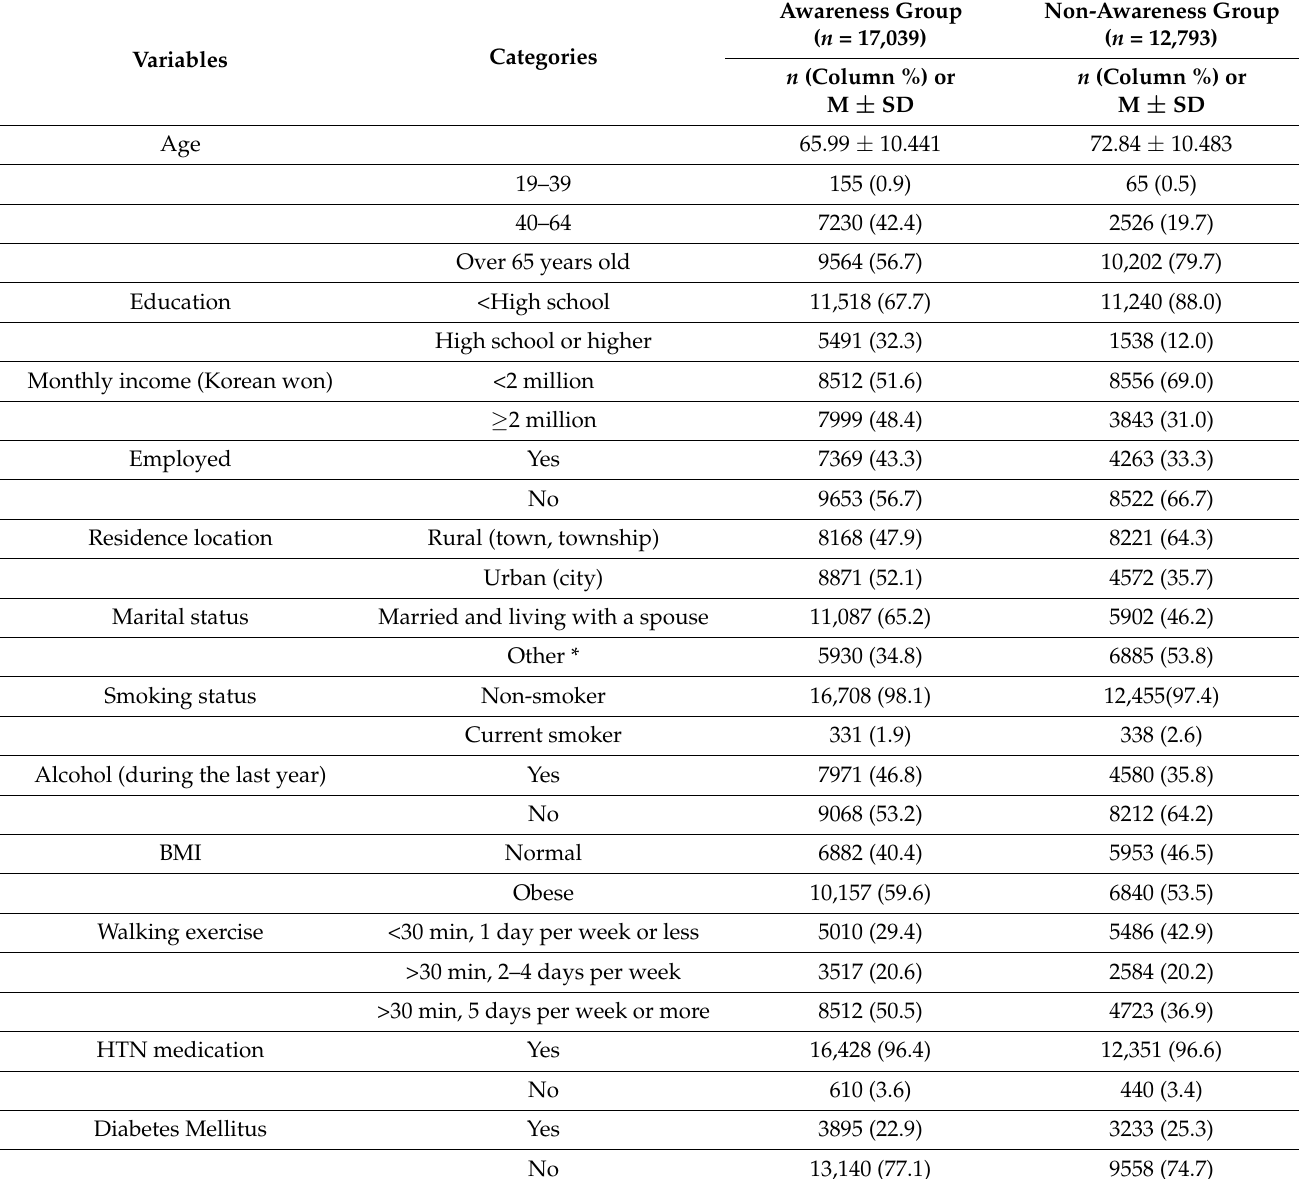
Table 1. General characteristics according to blood pressure level